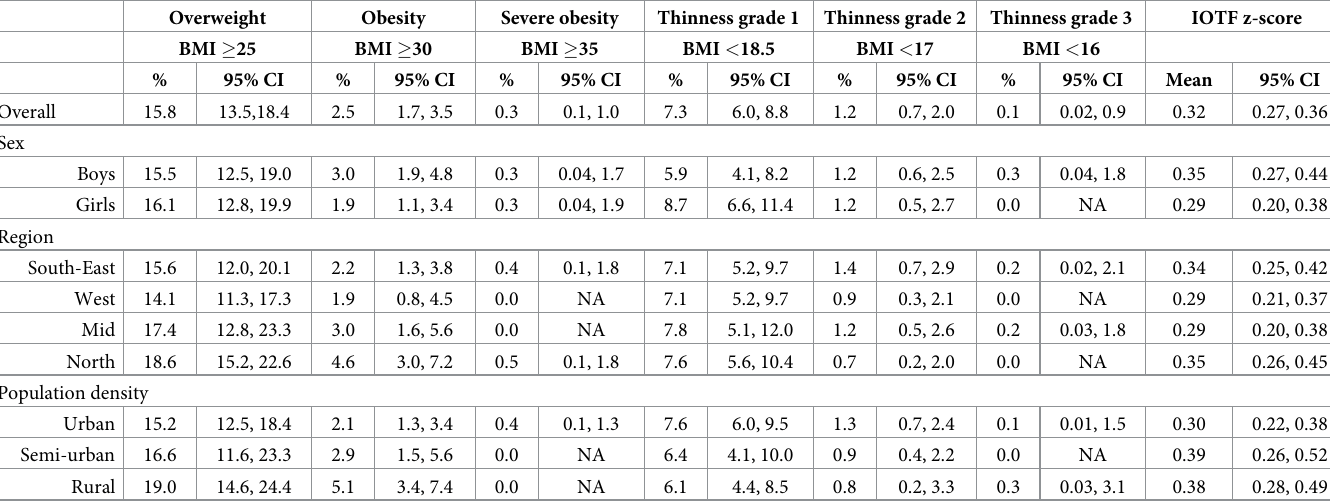
Table 2. Prevalence (%, 95% CI) � of IOTF † overweight, obesity, and thinness among Norwegian 13-year-olds and mean IOTF z-score ‡ (n = 1838).